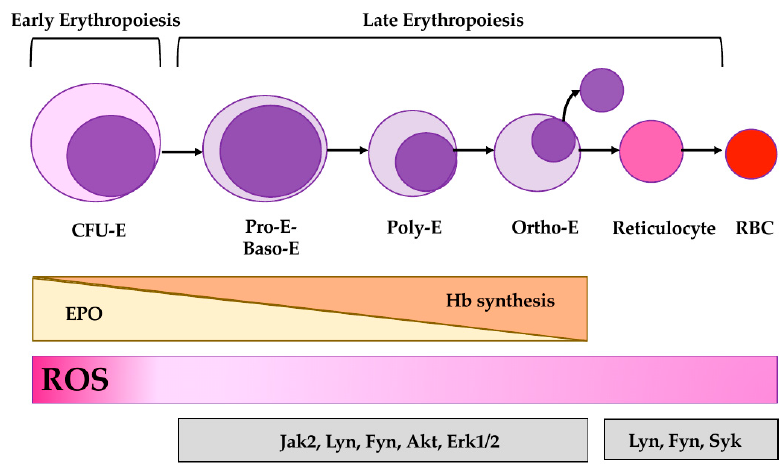
Figure 2. Schematic diagram of erythropoiesis. Early phase of erythropoiesis ends with the cell forming erythroid units (CFU-E), whereas the late phase of erythropoiesis starts with pro-erythroblasts through basophilic, polychromatic, and orthochromatic erythroblasts (E) towards enucleation with generation of reticulocytes, maturating into erythrocytes or red blood cells (RBCs). Erythropoiesis is regulated by erythropoietin (EPO), the signaling of which is associated with reactive oxygen species (ROS) production. The presence of free iron required for the biosynthesis of heme and the production of hemoglobin (Hb) contributes to oxidation in erythropoiesis. Jak2 kinase and Src family kinases (Lyn and Fyn) are involved in the EPO cascade. Redox interfaces these kinases and Akt towards mTOR-dependent autophagy.